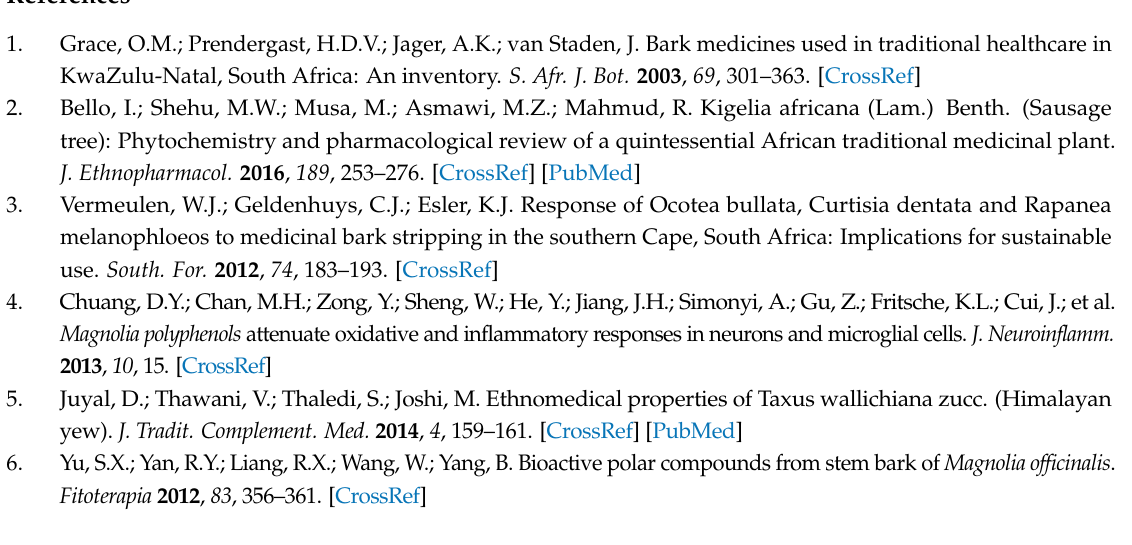
Figure S1: The representative HPLC-UV chromatogram ( λ = 254 nm) of Magnolia acuminnata bark extract; 1 - protocatechuic acid (tR = 6.3 min), 2 – catechin (tR = 8.8 min), 3 - elgaic acid (tR = 12.2 min), 4 - epigallocatechin gallate (tR = 14.8 min), 5 – epicatechin (tR = 19.2 min), Figure S2: The representative HPLC-UV chromatogram ( λ = 254 nm) of Taxus cuspidate bark extract; 1 - gallic acid (tR = 3.2 min), 2 - protocatechuic acid (tR = 6.3 min), 3 - chlorogenic acid (tR=9.2 min), 4 - p-hydroxybensoic acid (tR = 11.8 min), 5 - caffeic acid (tR = 15.2 min), 6 - hydroxycaffeic acid (tR = 15.8 min), Figure S3: The representative HPLC-UV chromatogram ( λ = 254 nm) of Catalpa speciosa bark extract; 1 - gallic acid (tR = 3.2 min), 2 - protocatechuic acid (tR = 6.3 min), 3 – catechin (tR = 8.8 min), 4- p-hydroxybensoic acid (tR = 11.8 min), 5 - vanillic acid (tR = 12 min), 6 -caffeic acid (tR = 15.2 min), 7 - p-coumaric acid(tR = 26 min), 8 - ferulic acid(tR = 34.4